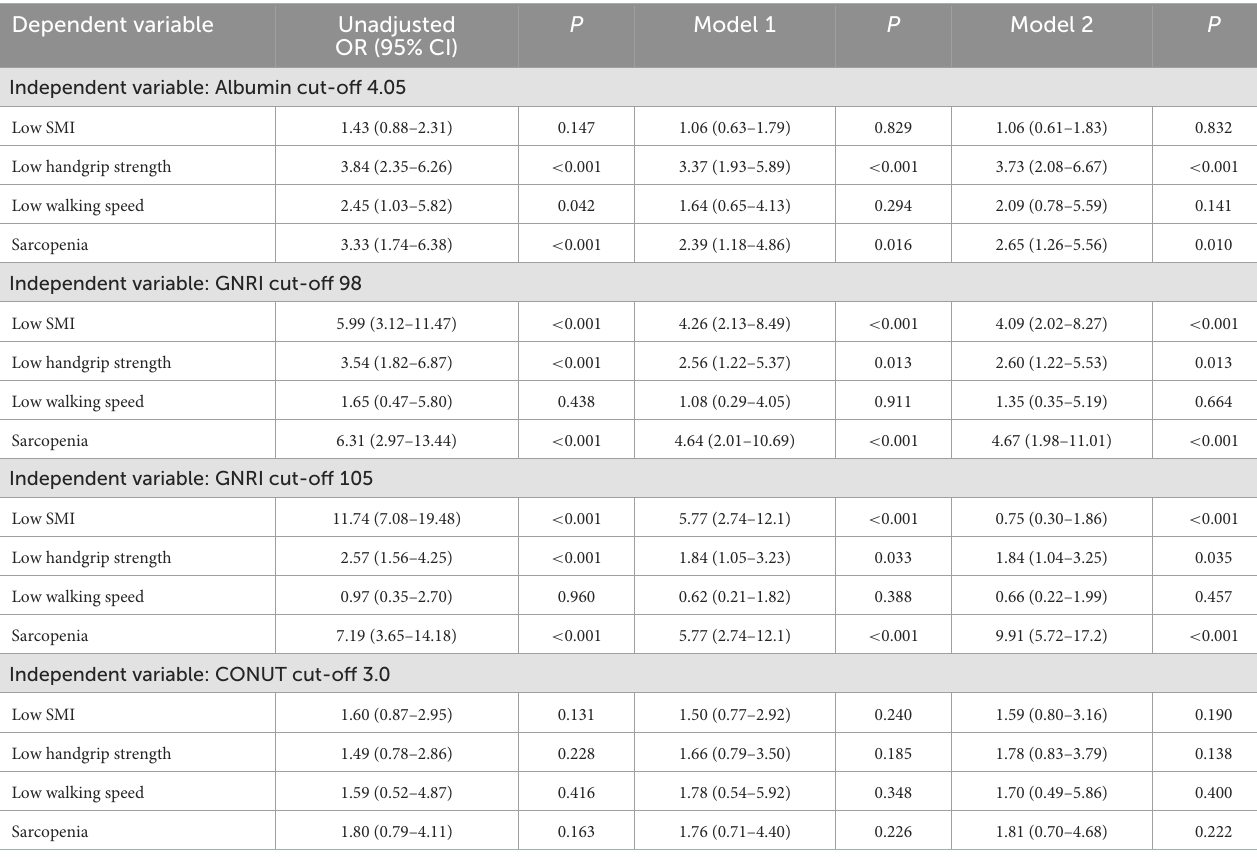
TABLE 4 Univariate and multivariate logistic regression analysis on associations of cut-off of nutritional indices with a diagnosis of sarcopenia in the overall participants. P Model 1 P Model 2 P Dependent variable Unadjusted OR (95% CI)